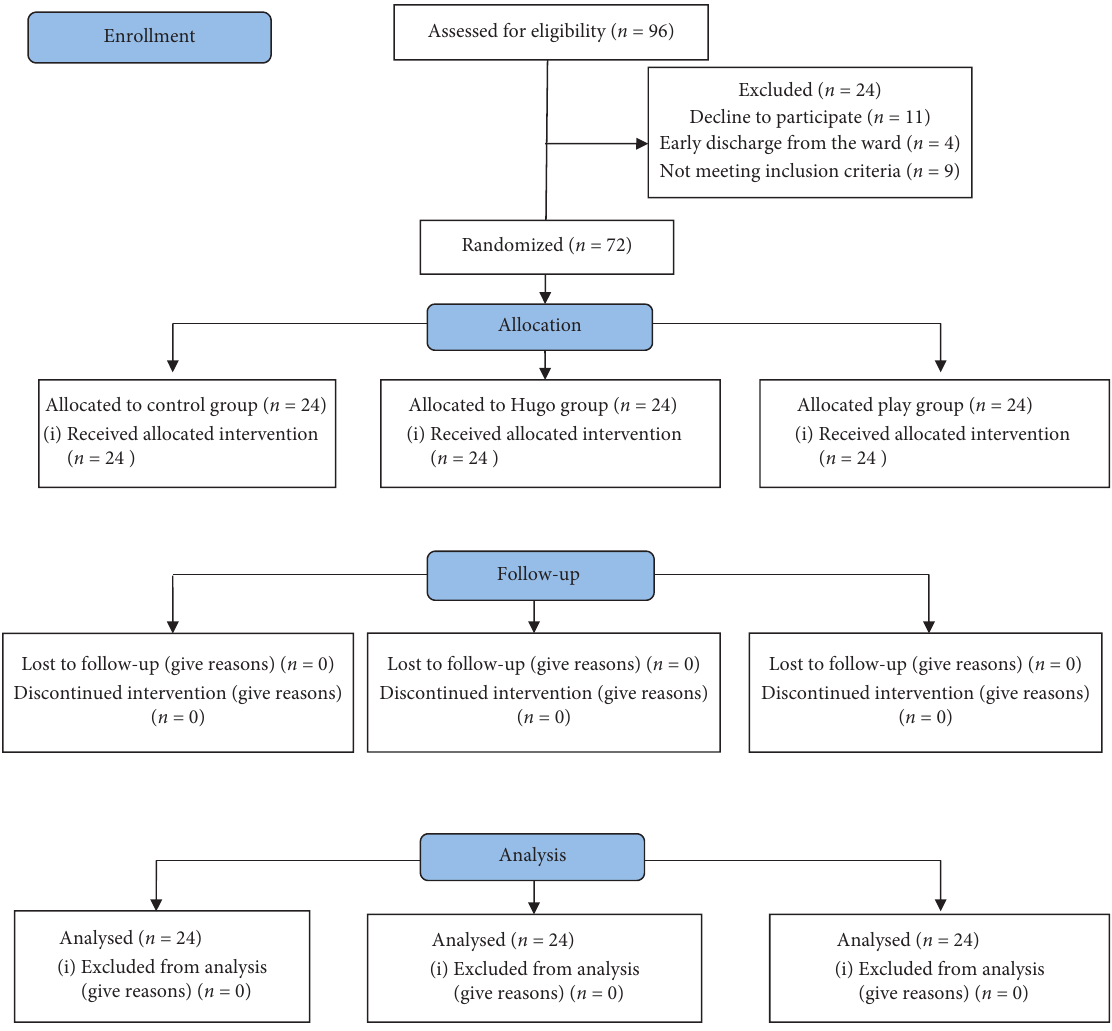
Figure 1: Consort flow diagram of the three study groups: control group; Hugo’s point massage group, and